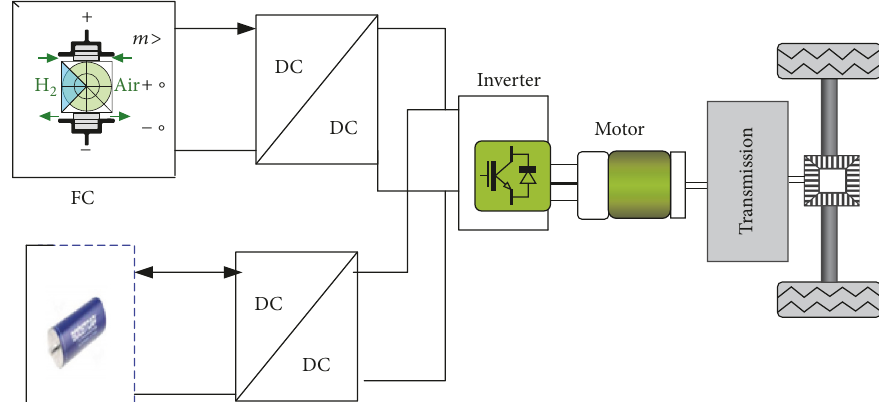
Figure 1: Electric vehicle system.